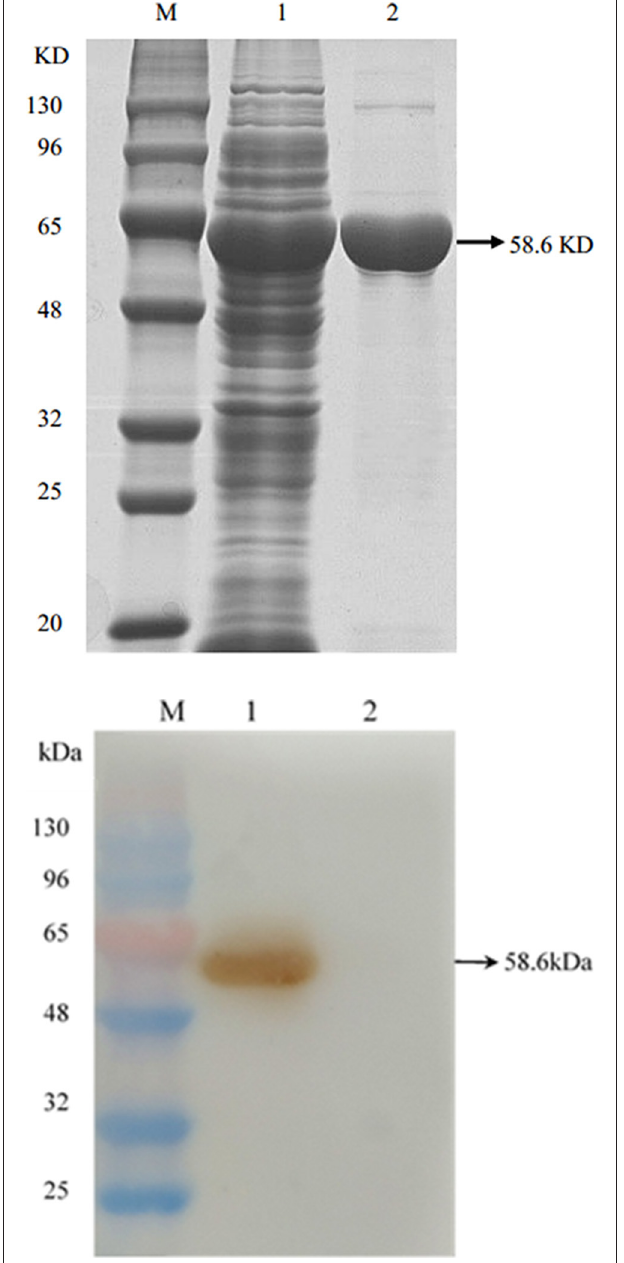
FIGURE 2 | The expression and identification of Omp2 protein. (A) SDS-PAGE analysis of Omp2 expressed in E. coli BL21. Lane M: protein molecular weight standard; lane 1: soluble fraction of the induced bacterial lysate, lane 2: purified Omp2 protein. (B) Western blotting analysis for Omp2. An anti- L. intracellularis -positive antibody served as the primary antibody. Lane M: the prestained protein molecular weight standard; lane 1: purified Omp2; lane 2: purified GST-tagged protein.